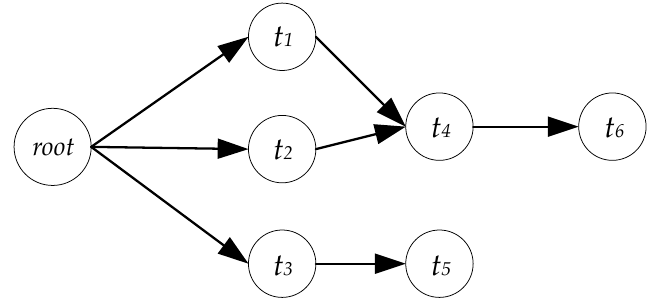
Figure 2. An example of the directed acrylic graph (DAG) with six